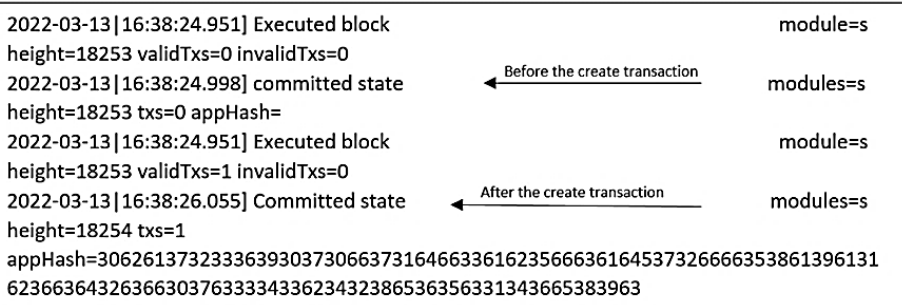
Figure 14. Block Creation.